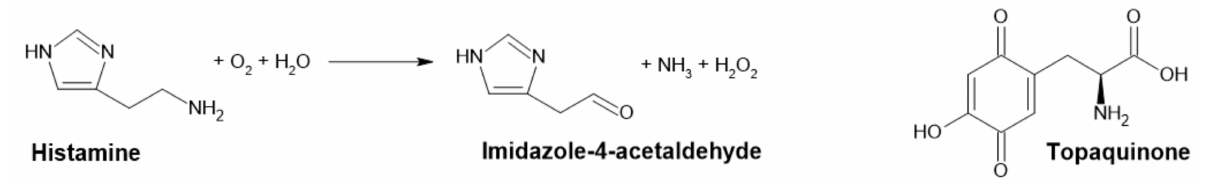
Figure 2. Reaction catalyzed by DAO and the structure of its cofactor